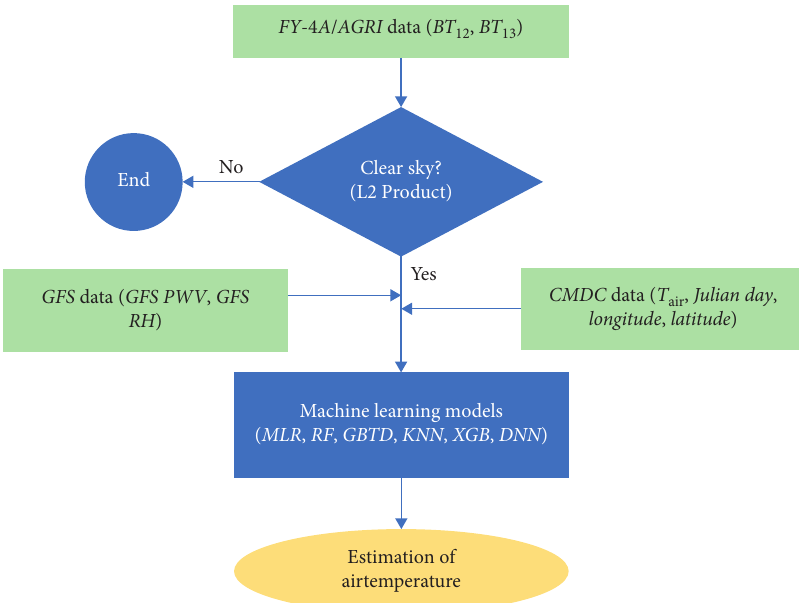
Figure 3: Flowchart of the T air estimation model in this